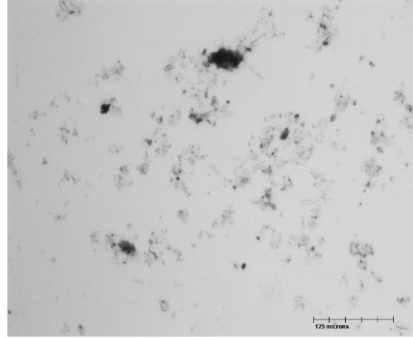
Figure 4. A photomicrograph of the eroded sediment for shear stress step of 0.33 Pa and age of deposit equal to 160